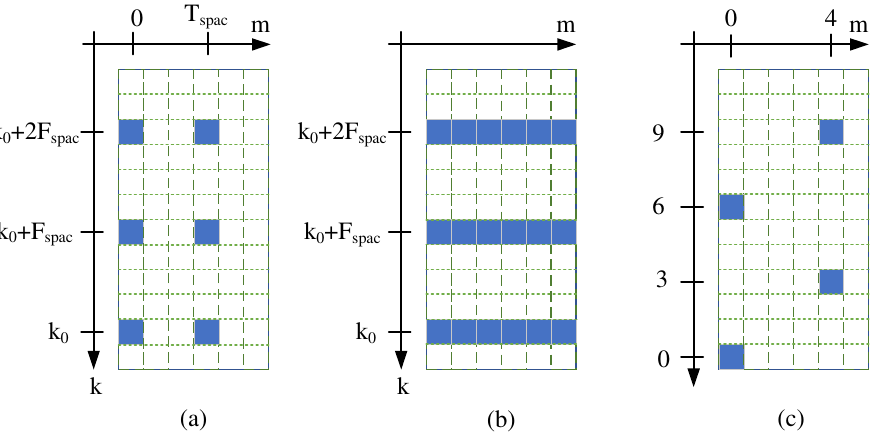
Figure 4. Pilot patters: ( a ) proposed pilot pattern; ( b ) comb-type; ( c ) Long Term Evolution Cell Specific Reference Signal (LTE CRS) pilot